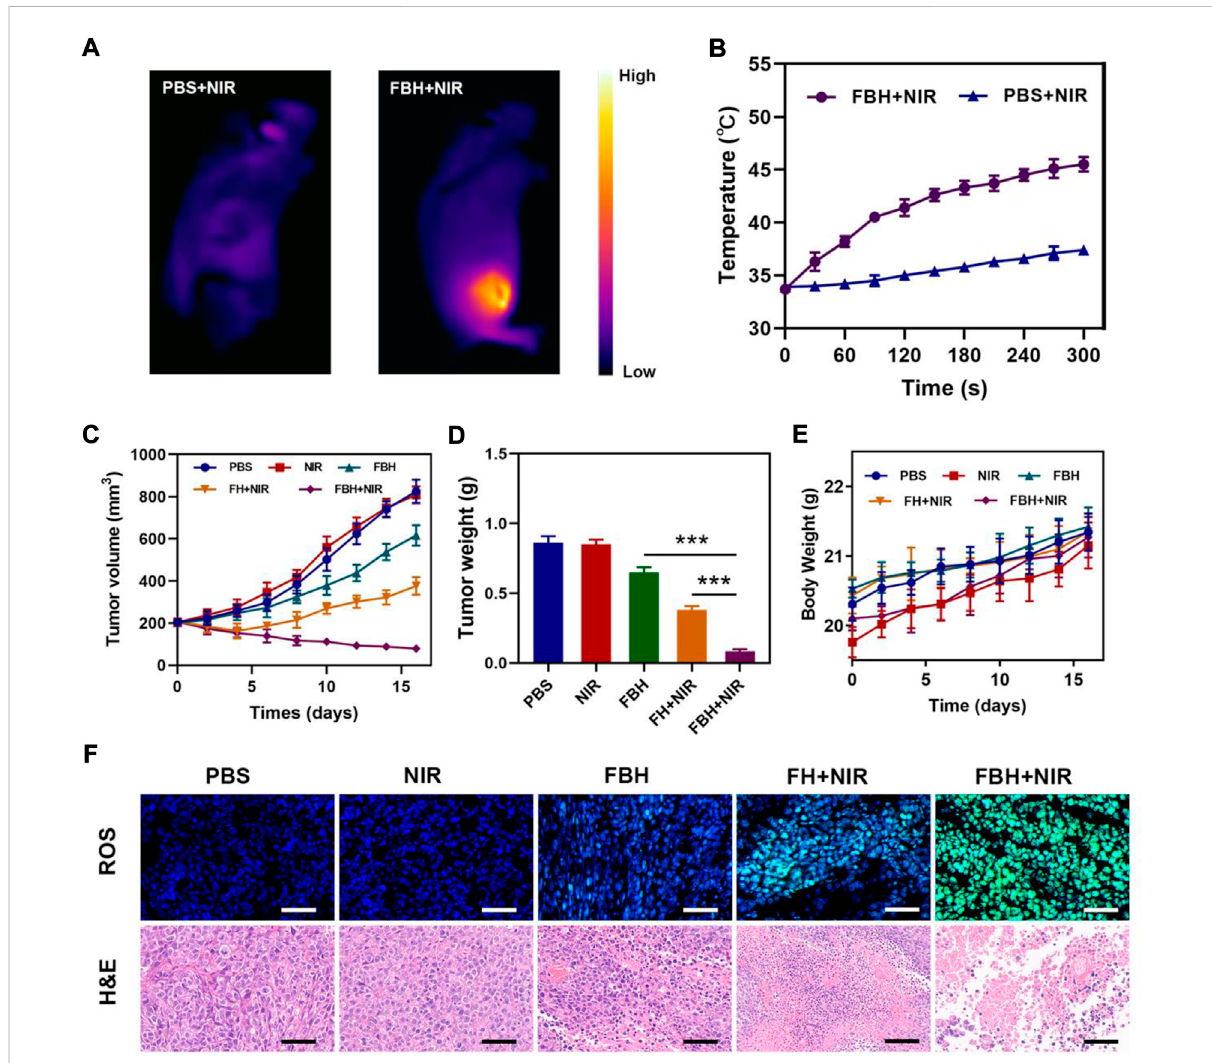
FIGURE 3 (A) Infrared thermal images of tumors in the speci fi ed treatment groups. (B) After being irradiated with 808 nm laser (0.5 W/cm 2 ) for 5 min, the temperature elevates in mice having 4T1 tumor, in the speci fi ed treatment groups. (C) The treatment groups ’ tumor volume alters over time (n = 5). (D) Averagetumorweightvaluesassociatedwiththeindicatedtreatments(n=5). (E) Changesinbodyweightinresponsetotheindicatedtreatments (n = 5). (F) HPF and H&E-stained tumor sections from the indicated treatment groups (n = 5). Scale bars: 100 μ m * p < 0.05, ** p < 0.01, *** p < 0.005; Student ’ s